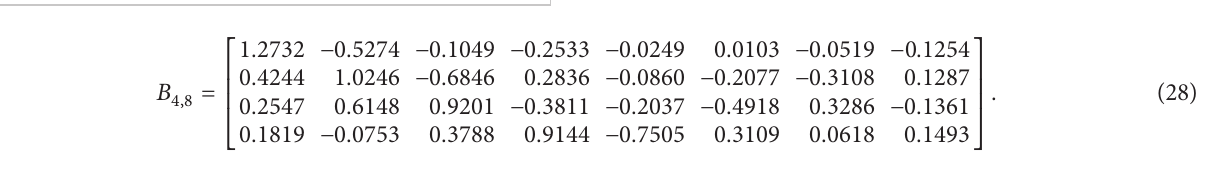
Figure 3: Bipolar pulse-width-modulated signal with amplitude 𝑉 and switching time instants 𝑡 (𝑠) 𝑖